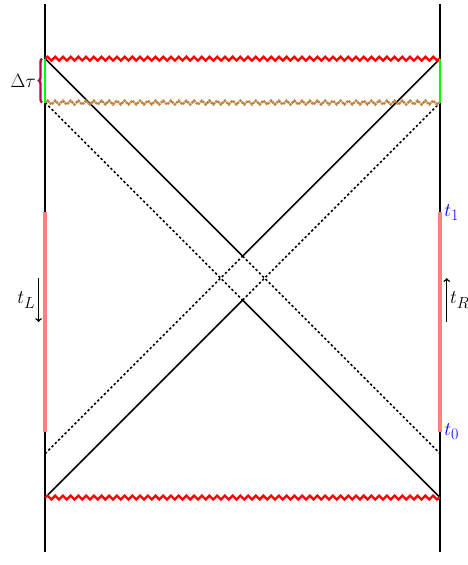
Figure 6 . Penrose diagram of the traversable wormhole is depicted in this (cid:12)gure. The left-right boundaries are now causally connected as the wormhole becomes traversable. The shape of the upper singularity is not precise as it is curved in